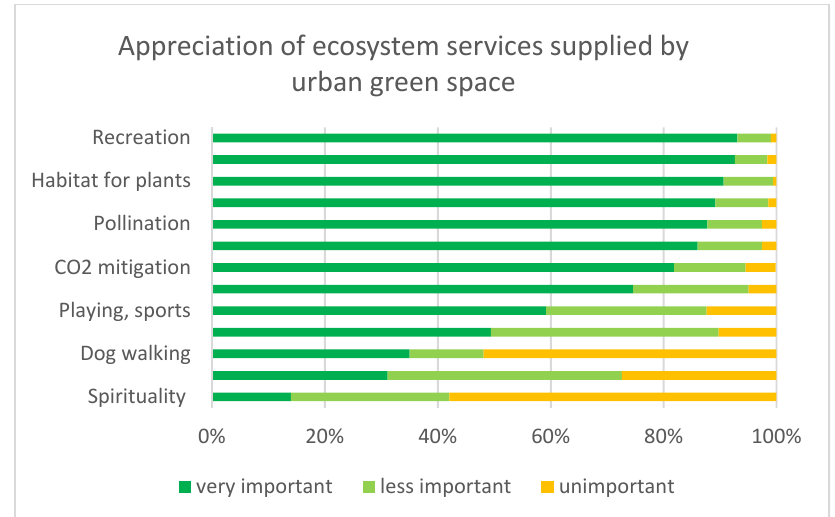
Figure 11. Appreciation of ecosystem services supplied by urban green space in the three cities (source: authors’ elaboration).